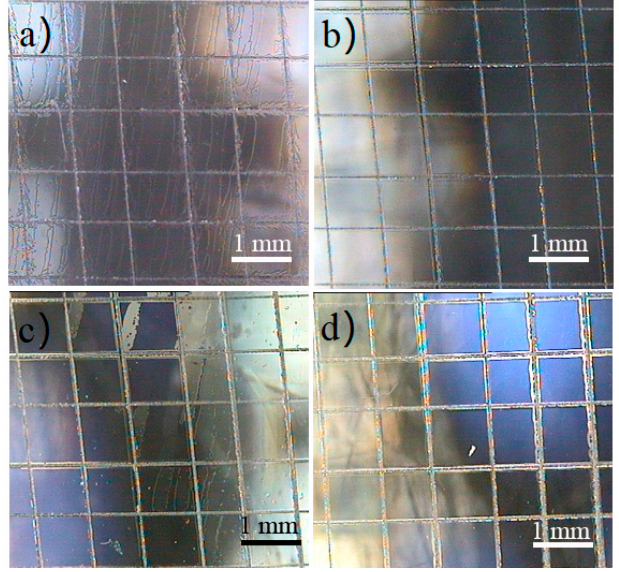
Figure 5. Microscope images of scratching squares on No. 6 sample: ( a ) position A, ( b ) position B, ( c ) position C, and ( d ) position D.